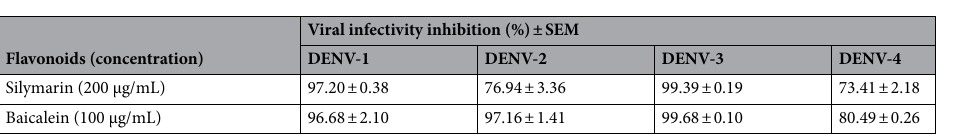
Table 6. Virucidal activity of silymarin and baicalein against all four dengue serotypes. Data were acquired from three independent experiments and presented as mean ± standard error mean (SEM).